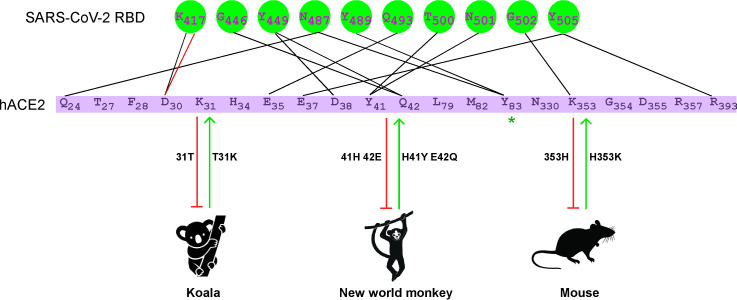
The genetic determinants of ACE2 required for SARS-CoV-2 entry.Mouse, koala, and New World monkey ACE2 cannot serve as functional receptors to support SARS-CoV-2 entry, as determined by different genetic restrictions. Position 31 in koala ACE2 is Thr whereas that in human is Lys. Substitution of Thr with Lys in koala ACE2 allowed for binding to the SARS-CoV-2 spike and viral entry. Different from koala ACE2, the genetic restriction of mouse ACE2 His353. Lys353 in human ACE2 can hydrogen bond with Gly502 of the SARS-CoV-2 spike protein, stabilizing the ACE2-spike complex. The presence of His at this position in mouse ACE2 disrupts this interaction. However, humanization of mouse ACE2 at position 353 renders the protein supportive of SARS-CoV-2 entry. The genetic determinants of New World monkey ACE2 were localized at positons 41 and 42 as we previously reported[20]. Thus, three genetic determinants of the ability of ACE2 to serve as the SARS-CoV-2 receptor were identified by comparative analysis of ACE2 orthologs, and the receptor activities of normally non-susceptible ACE2 orthologs could be rescued by genetic modification.